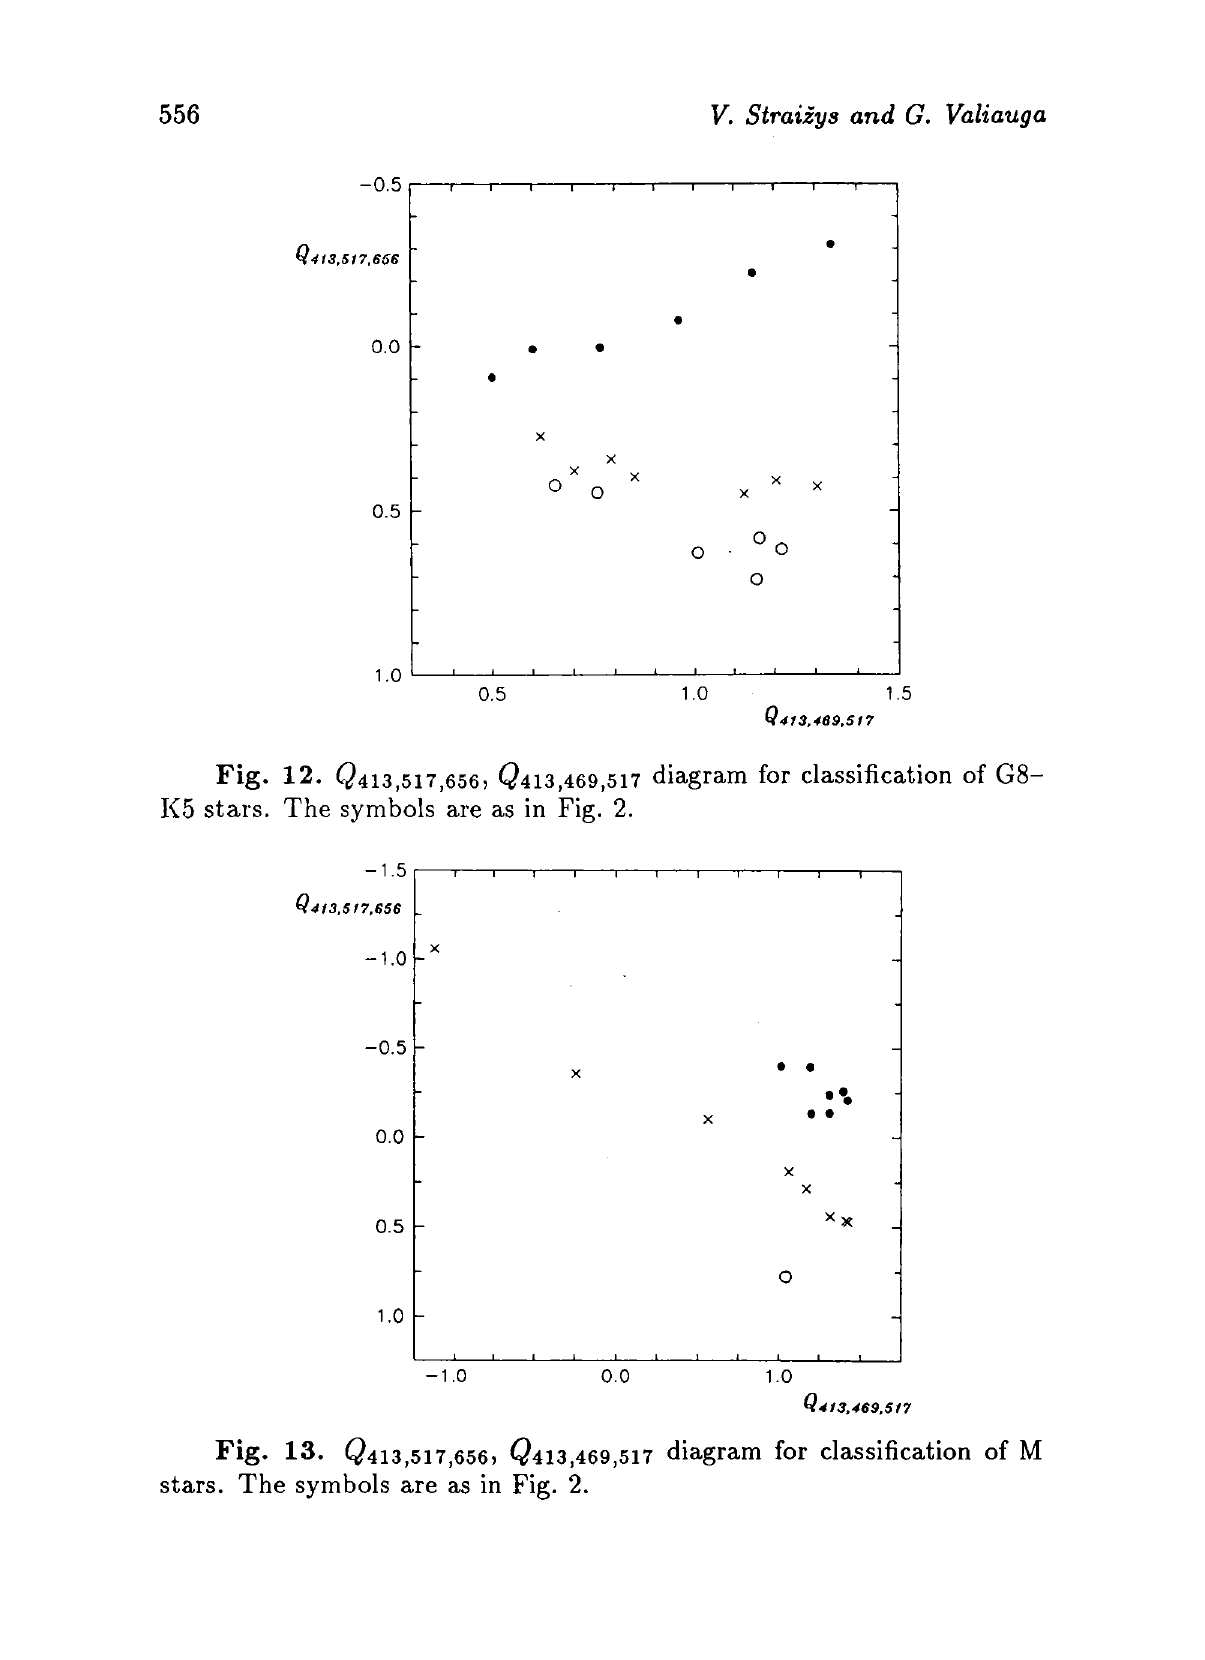
Fig. 13. Q413,517,656, $413,469,517 diagram for classification of M stars. The symbols are as in Fig.